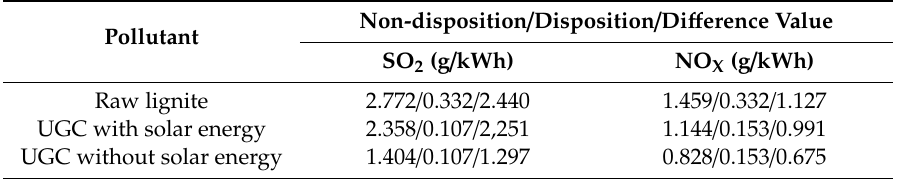
Table 14. Comparison of flue gas composition with and without removal device.